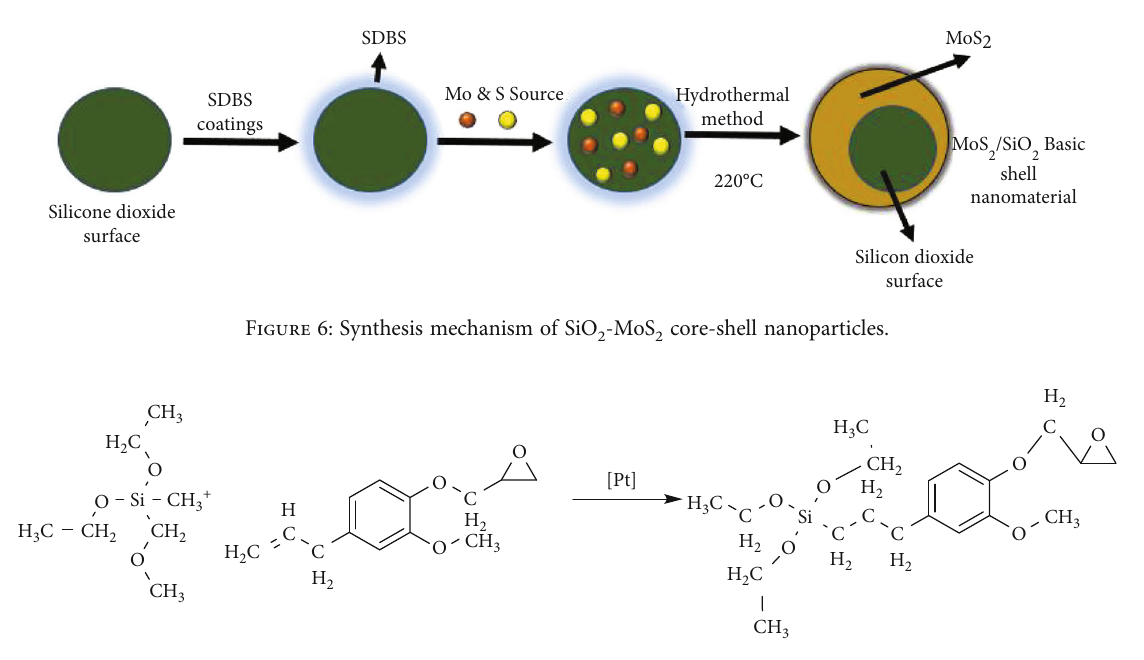
Scheme 4: Silicone-bonding agents based on eugenol preparation.